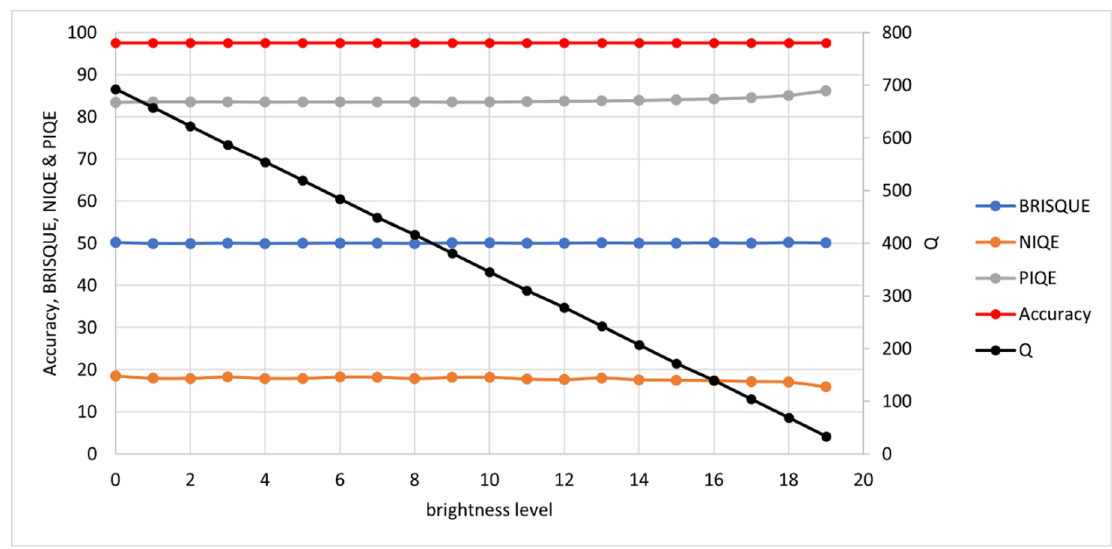
Figure 8. OCR Accuracy and Quality Metrics vs. Brightness Level. Note: high BRISQUE, NIQE and PIQE values denote low quality while high Q values denote high quality. Again, a separate axis is used for Q here as the unnormalized Q value tends to be considerably higher than the other NR-IQAs, which tend to stay in the range 0 to 100.